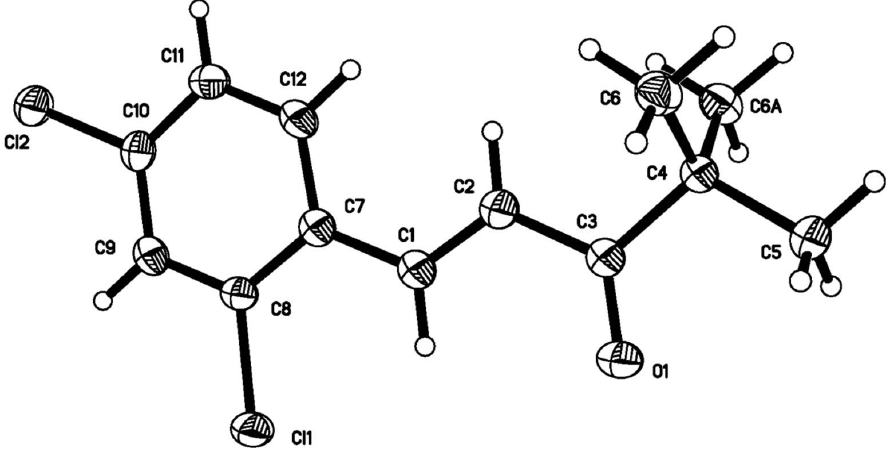
Figure 1 Molecular structure showing 30% probability displacement ellipsoids.H atoms are omitted for